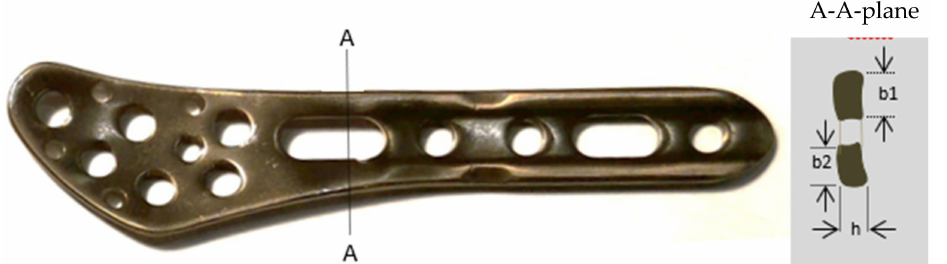
Figure 3. The plate with its most predisposed bending area (A-A) and dimensions of the anterior ( b 1 = 4 mm) and posterior ( b 2 = 3 mm) branches. For both branches, h was the same, equal to 2.3 mm.